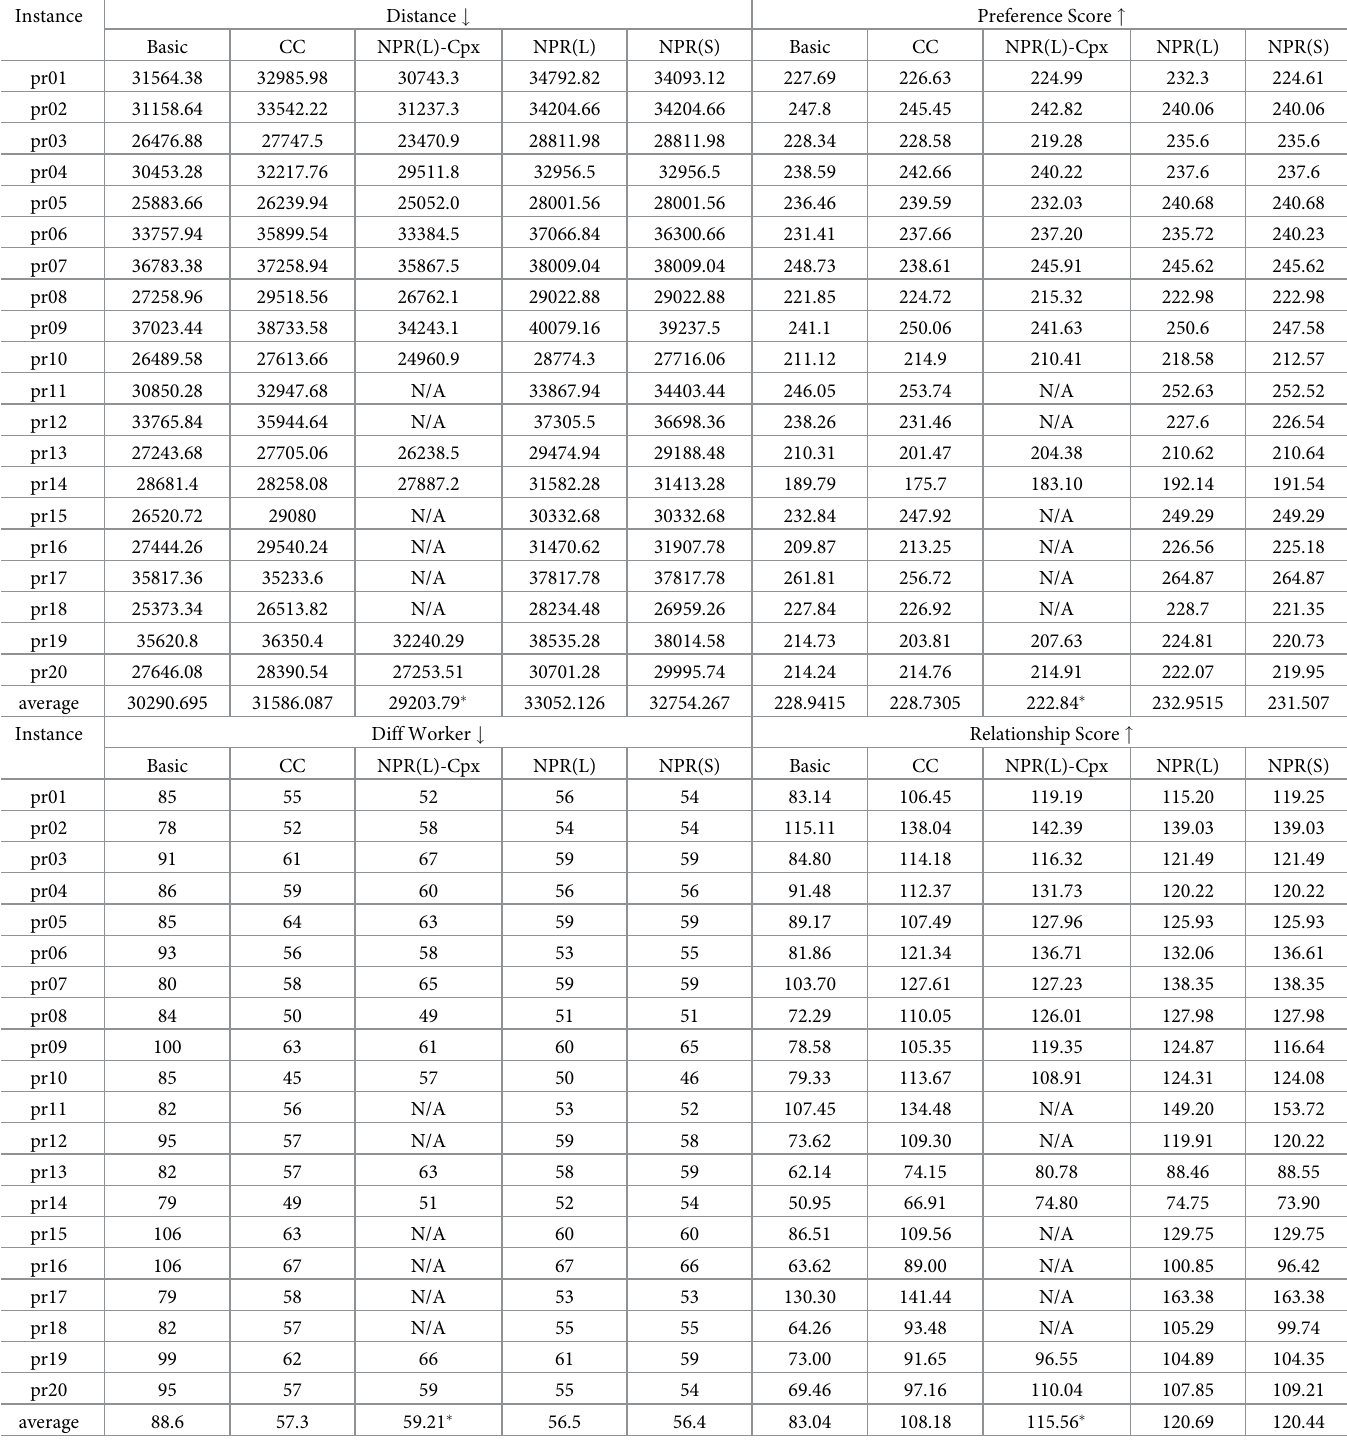
Table 5. The objective function values of the solution obtained from the five models. The symbol # indicates the lower the objective value the better, while " indicates the